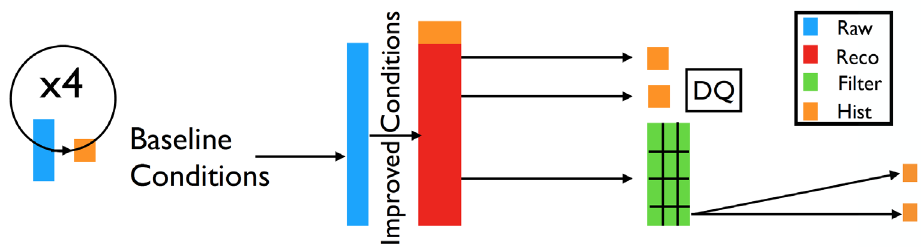
Figure 3. A schematic of the main components of the data preparation workflow for NA62.